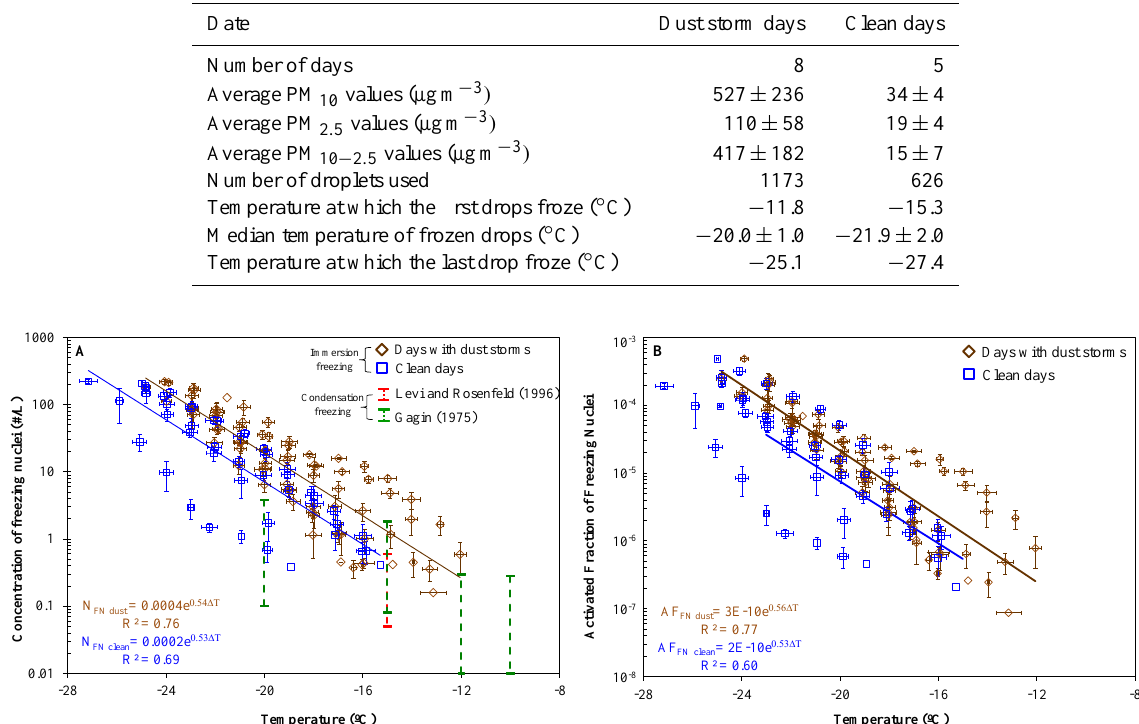
Figure 7. Freezing nuclei concentration (A) and activated fraction values (B) with standard deviation, calculated for clean (blue) and dust storm (brown) days. Best-fit lines and the equations that represent them are also shown. For comparison in (A) the ice nuclei concentrations measured in Israel near cloud base by Gagin (1975) (green bars) and ground measurements by Levi and Rosenfeld (1996) (red bars) are also